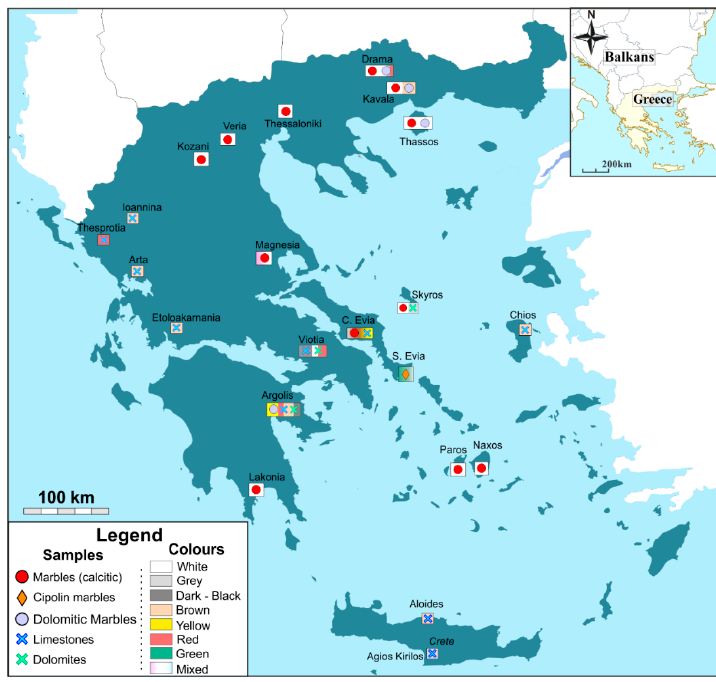
Figure 1. Map of Greece indicating the sample localities.